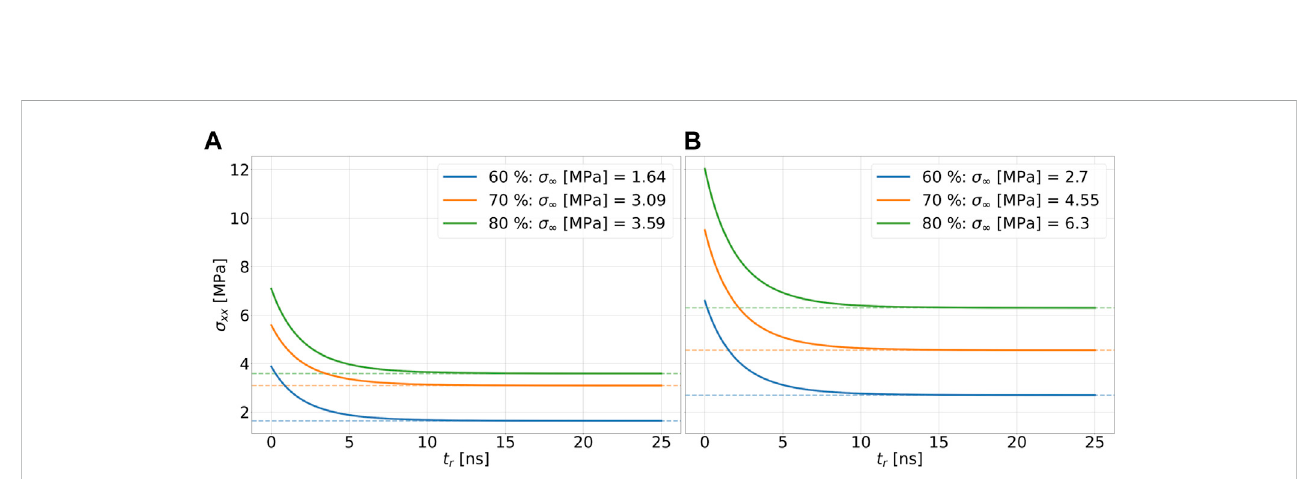
FIGURE 6 Fit of stress-strain data from relaxation tests for a strain rate of 10 7 1/s using the Prony series for the systems with a polymer chain to linker ratio of 2 to 1. The dashed lines are plotted on the stress values of the relaxed stresses of the respective systems. The total strain of the systems is .1 in (A) and .325 in (B) .